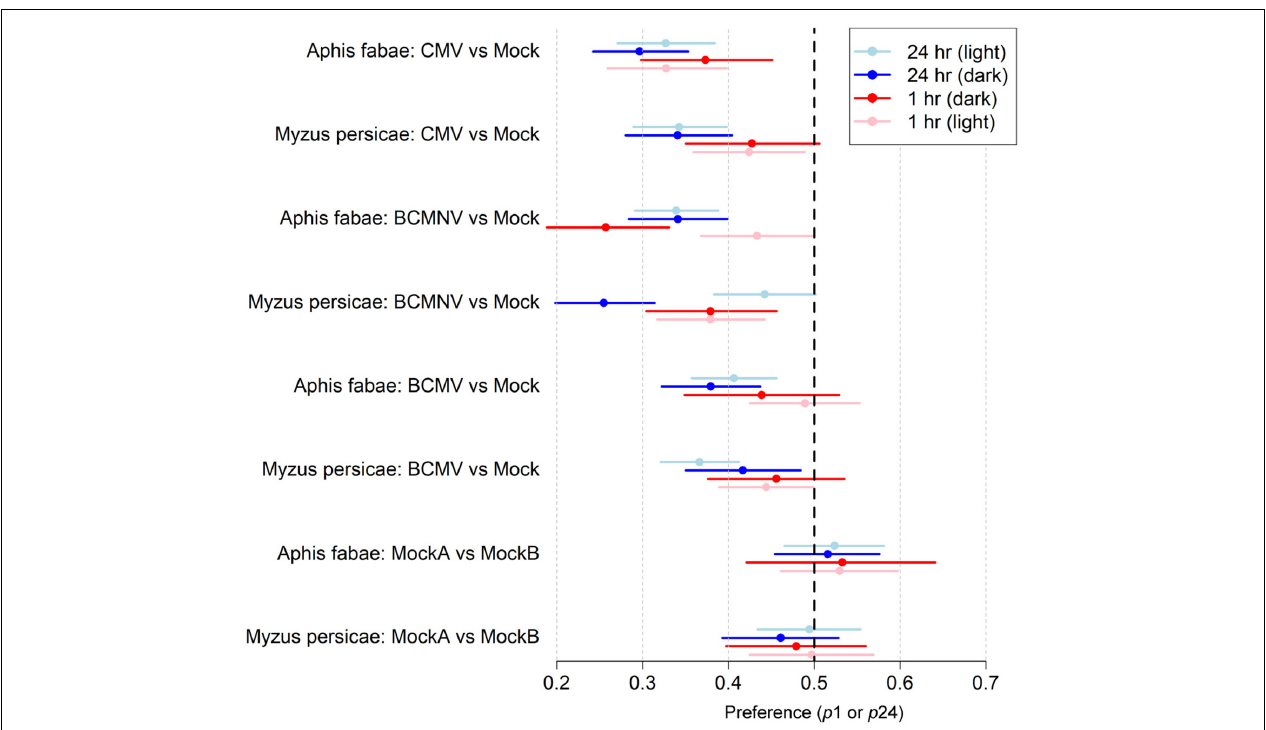
FIGURE 1 | The probability of aphids choosing to settle on mock-inoculated plants is higher than on virus-infected plants. Summary of the data obtained from aphid free choice assays performed under normal illumination and in darkness ( Tables 1 , 2 ). Data is expressed so that a lower probability value for settling on virus-infected plants indicates a higher preference for aphids to settle on mock-inoculated plants (Tungadi et al., 2017). Twenty-five wingless aphids were placed equidistantly between a mock-inoculated plant and a virus-infected plant [inoculated with either cucumber mosaic virus (CMV), bean common mosaic virus (BCMV), or bean common mosaic necrosis virus (BCMNV)]. Individuals of both aphid species ( A. fabae and M. persicae ) preferred to settle on uninfected plants both under normal illumination ( Table 1 ) and in darkness ( Table 2 ) after 1 and 24 h. All the credible intervals were statistically significant for all virus-infected vs. mock-inoculated plant combinations except for M. persicae on BCMNV-infected plants under normal illumination (95% credible interval 0.38–0.050). Aphids did not distinguish between two mock-inoculated plants at either 1- or 24-h either under normal illumination or in continuous darkness. The X -axis shows the range of the 95% credible interval of the parameters, p 1 and p 24 that are the probabilities of choosing to settle on an infected plant conditional on settling at t = 1 h and t = 24 h, respectively. The colored dots represent the mean, and the colored lines represent the credible interval. The dotted vertical black line represents equal probability. TABLE 2 | Analysis of aphid settling choices in different choice test combinations in darkness. Choice Test Aphis fabae Myzus combinations